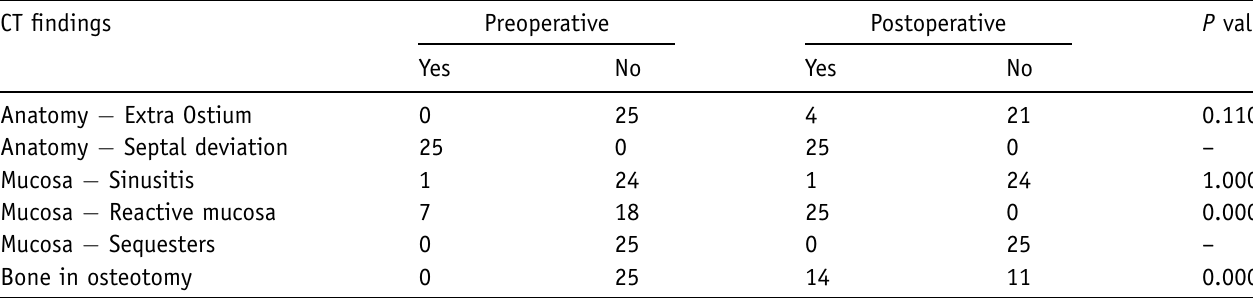
Table IV. CT scan fi ndings (Fischer ’ s exact test).